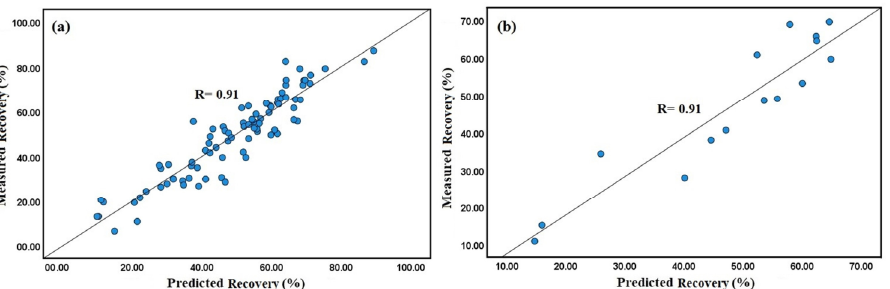
Figure 11. The correlation between the experimental values and predicted values obtained using the MLR ( a ) training ( b ) validation.